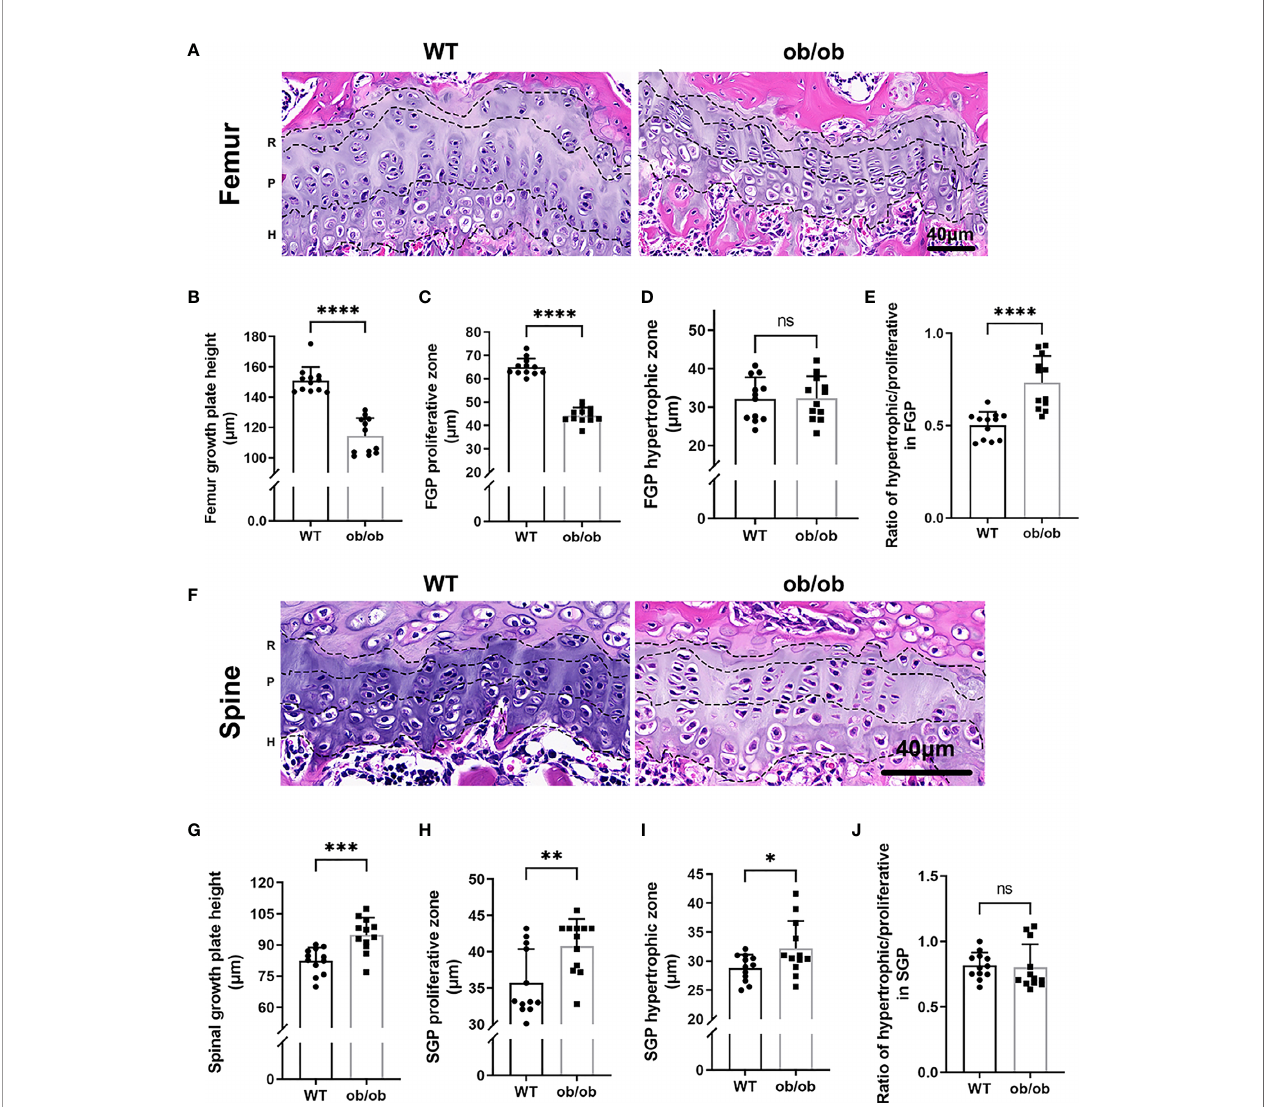
FIGURE 2 | Comparison of femur and vertebrae growth plate length, proliferative and hypertrophic zone between wild type mice and ob/ob mice at the end of 8 weeks using HE staining method. R, resting zone; P, proliferative zone and H, hypertrophic zone. (A) Femur growth plate HE staining; (B) The height of femur GP; (C) The height of proliferative zone in femur GP; (D) The height of hypertrophic zone in femur GP; (E) Ratios of proliferative/hypertrophic zones in femur GP; (F) Spinal growth plate (SGP) HE staining; (G) The height of SGP; (H) The height of proliferative zone in SGP. (I) The height of hypertrophic zone in SGP; (J) Ratios of proliferative/hypertrophic zones in Spinal GP. Scale bar: 40 m m; n=12 each group. Values are means±SD, * P < 0.05, ** P < 0.01, *** P < 0.001 and **** P < 0.0001, ns denoted not signi fi